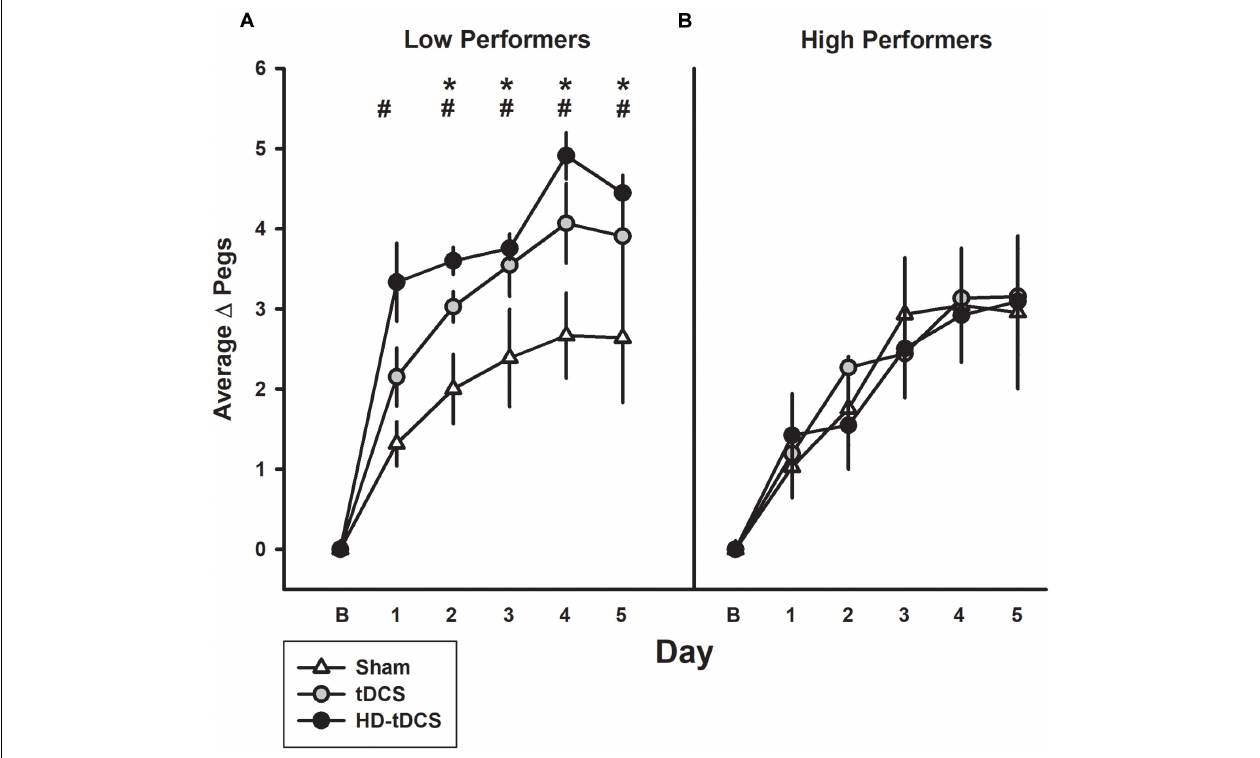
FIGURE 4 | Effect of performance status on motor learning enhancement. (A) Low performers (baseline PPT L below the median score) demonstrated marked separation of PPT L learning curves with tDCS (gray circles) and HD-tDCS (black circles) outperforming sham (white triangles). (B) Treatment group effects were not observed for high performers. B refers to baseline. ∗ p < 0.05 for sham vs. tDCS, # p < 0.05 for sham vs.